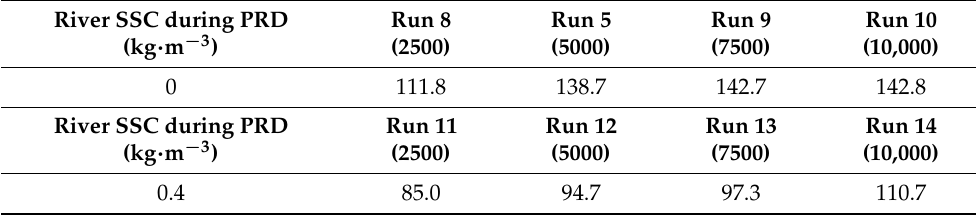
Figure 16. Recovery times of the ETM indicated by the NSE when ( a ) the river SSC is set to 0 and ( b ) the river SSC is set to 0.4 kg·m − 3 . Dashed lines indicate 0.90. Note the vertical axis range differs. Table 5. Recovery time (unit: hour) of the ETM after PRD with peak discharge (unit: m 3 ·s − 1 ) shown in the parentheses.